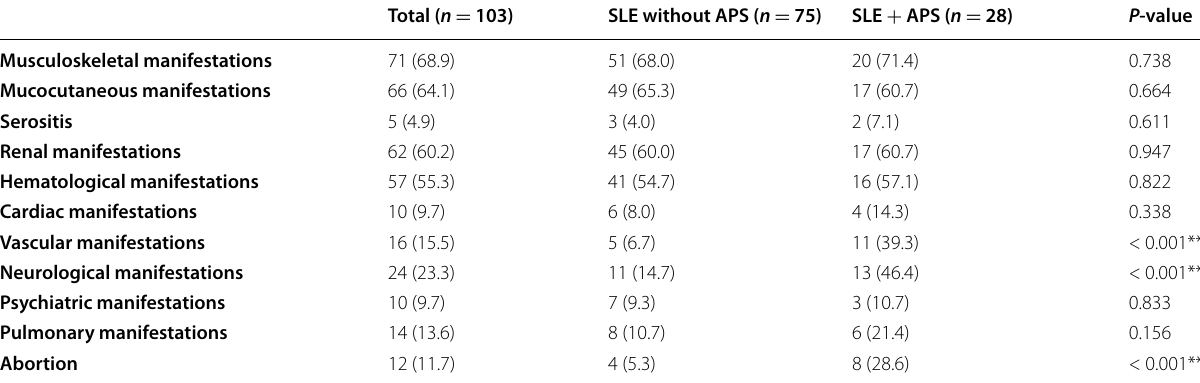
Table 2 Clinical manifestations of the studied patients